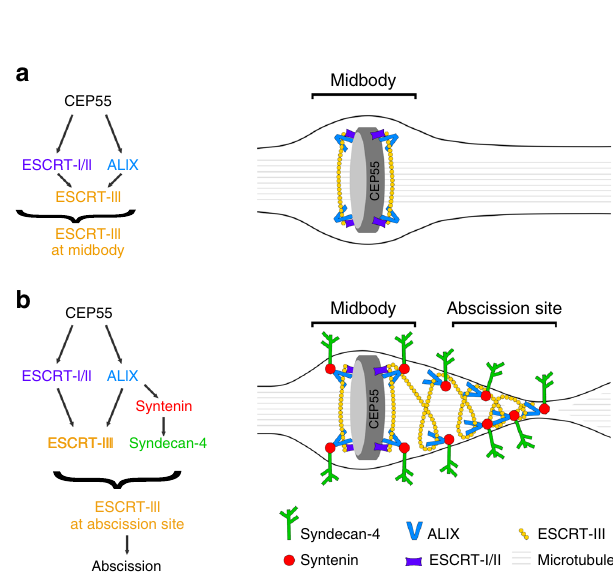
Fig. 6 Working model: ALIX-syntenin-syndecan-4 couples the ESCRT-III machinery to the plasma membrane at the abscission site for ef fi cient scission. a ESCRT-III localization at the midbody depends on its recruitment by ALIX (blue) and ESCRT-I/-II (violet), which are targeted to the midbody by MKLP1-associated CEP55 (gray). This fi rst step does not require syntenin or syndecan-4. b ESCRT-III localization at the abscission site, located on one side of the midbody, depends on the tripartite ALIX- syntenin-syndecan-4 module. ALIX-syntenin (red), by directly coupling ESCRT-III (yellow) on the one hand and the transmembrane protein syndecan-4 (green) on the other hand is proposed to help maintain ESCRT- III polymers at the abscission site until the fi nal